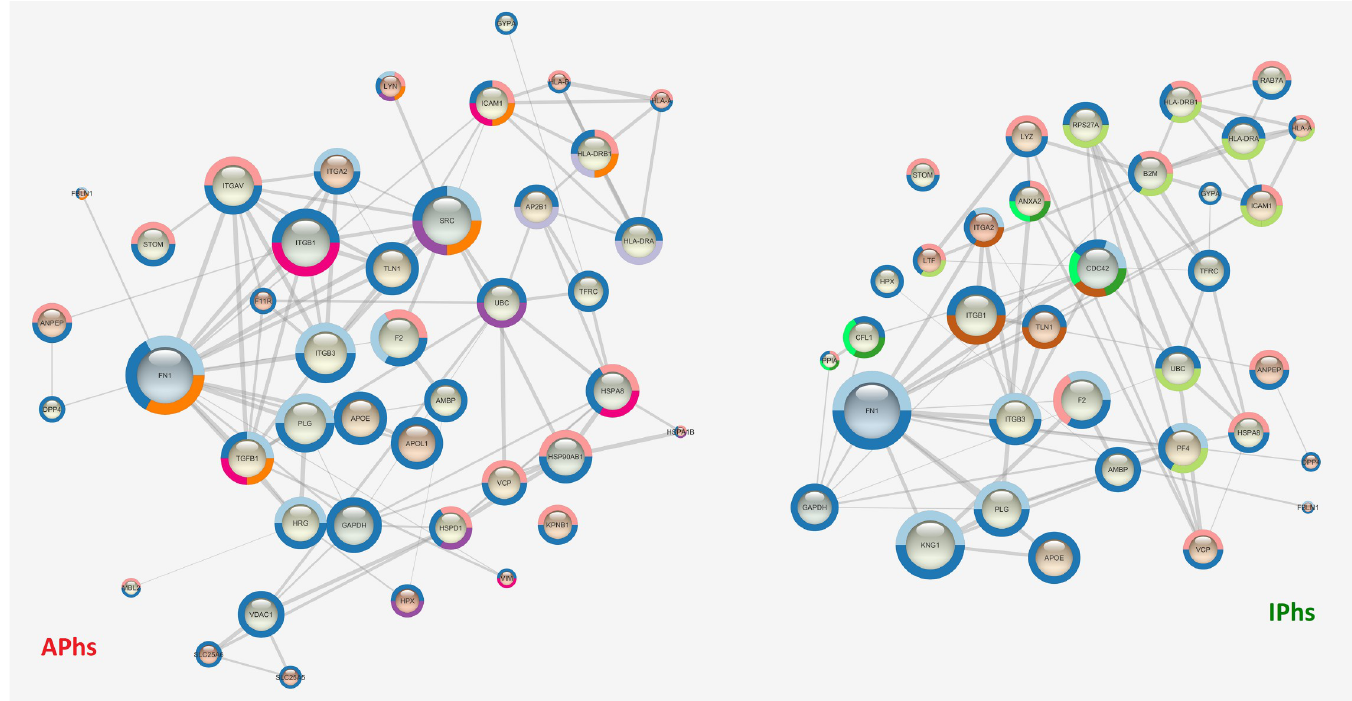
Fig 9. Networks of interspecies interaction between organisms. The networks of GO Biological Process Term “Interspecies interaction between organisms” for APhs (46 proteins; FDR = 4.37E-14) and IPhs (39 proteins; FDR = 2.97E-15) are shown. The two networks are very similar in the protein number and interaction confidence, but the signalling is based on different proteins: Src, Lyn, several Integrins (ITGAV, ITGB1, ITGB3, ITGA2), TGF- β 1 in APhs vs Ccd-42, Annexin 2 in IPhs.